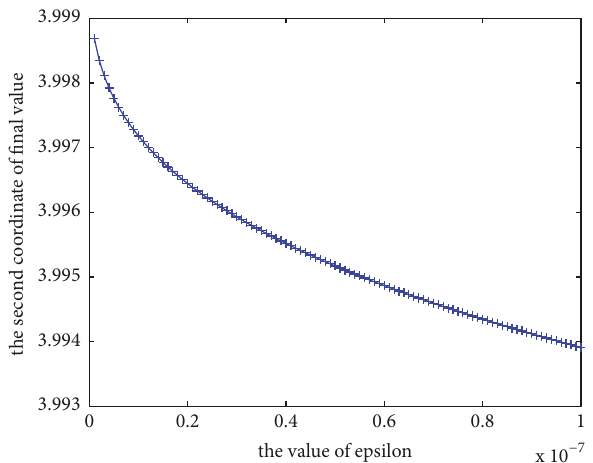
Figure 2: The behaviors of the second coordinate of 𝑥 for different 𝜖